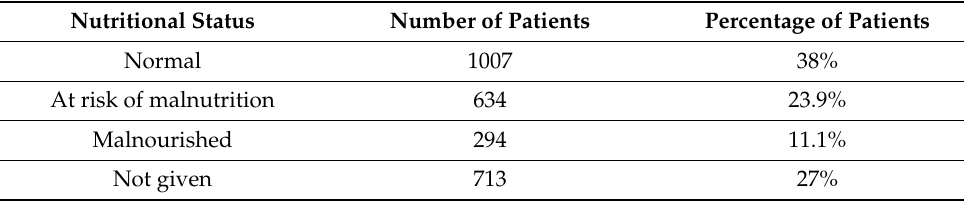
Table 8. Nutritional status of patients using the MNA questionnaire.